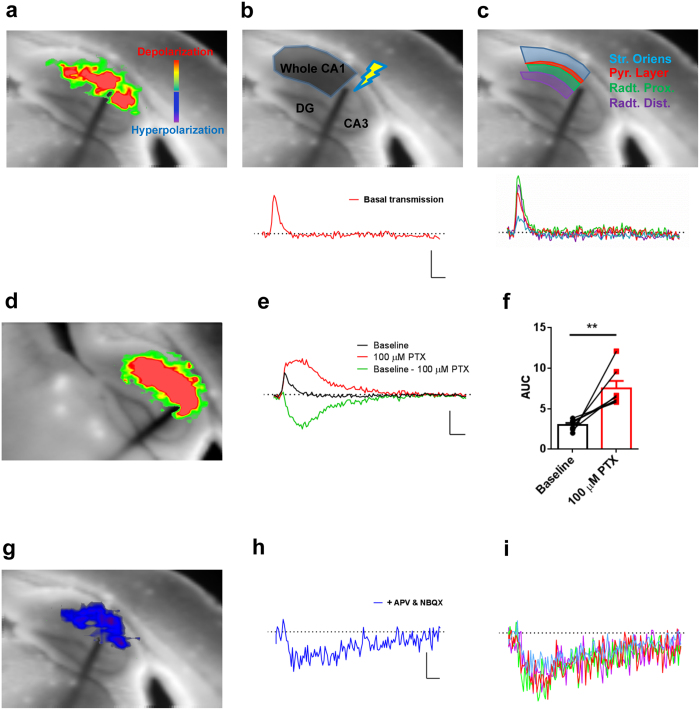
Blockade of ionotropic glutamatergic transmission reveals network hyperpolarization throughout CA1.(a) Representative frame showing VSDI-recorded depolarization activity after stimulation of Schaffer’s collateral in drug-free ACSF. Inset color scale indicates depolarization (green to red) and hyperpolarization (blue to purple). (b,c) Representative regions of interest (ROIs) arrangement (upper panels) and corresponding traces (lower panels) showing resulting average VSDI-recorded depolarization in drug-free ACSF from a ROI covering the whole CA1 (b) and in its different sub-regions (c). Str. Oriens = stratum oriens, Pyr. Layer = Pyramidal Layer, Radt. Prox. = radiatum proximal, Radt. Dist. = radiatum distal. (d) Representative frame showing VSDI-recorded depolarization activity after stimulation of Schaffer’s collateral following application of Picrotoxin (PTX, 100 μM). (e) Representative traces showing the impact of GABAergic transmission on VSDI-recorded depolarization from a ROI covering the whole CA1 before (Baseline) and after application of PTX. The GABAergic component (Baseline – 100 μM Picrotoxin) is obtained from the difference between Baseline and PTX conditions, respectively. (f) Quantification through area under curve (AUC) calculation of VSDI-recorded depolarization in the whole CA1 before (Baseline) and after application of PTX. n = 7 slices from 5 mice. Bars represent mean ± s.e.m. whereas over imposed lines are single values. **p < 0.01, two-tailed paired t-test. (g) Representative frame showing VSDI-recorded hyperpolarization activity after stimulation of Schaffer’s collateral in presence of blockers of ionotropic glutamatergic transmission (APV & NBQX). (h,i) Representative traces showing VSDI-recorded hyperpolarization activity following APV & NBQX application from a ROI covering the whole CA1 (h) and in its different sub-regions (i). Scale bars are 25 milliseconds on X-axis and 0.2% ΔF*F−1 on y-axis for traces in (b,c,e) whereas 0.05% ΔF*F−1 on y-axis for traces in (h,i).